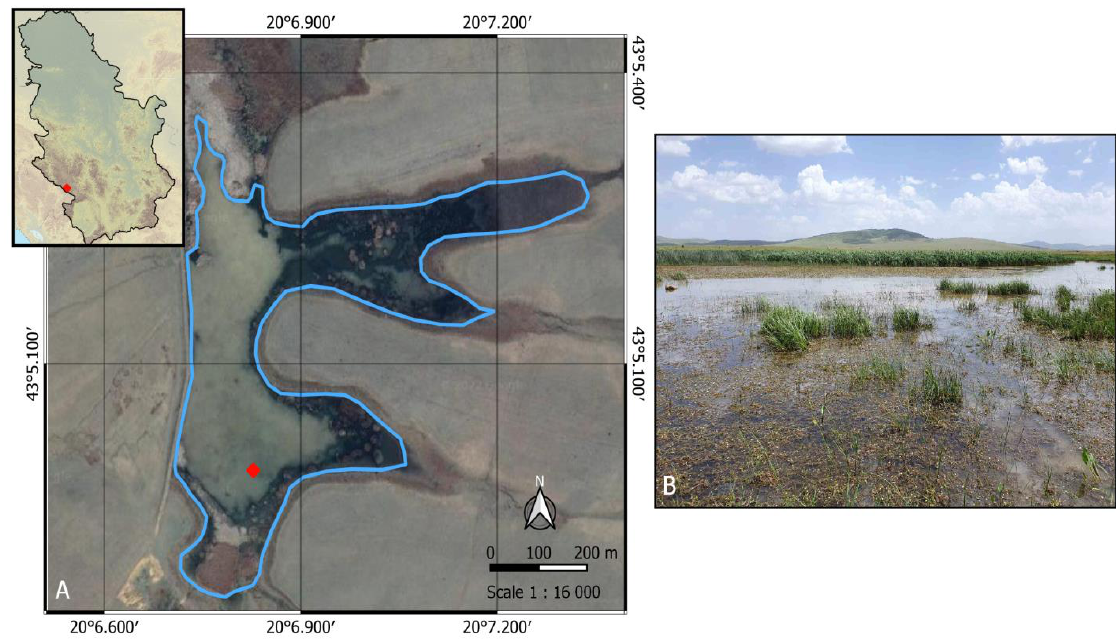
Figure 1. A. The position of Karameidan Lake in Serbia. B. Locality where Dixella aestivalis was found in the Karamejdan